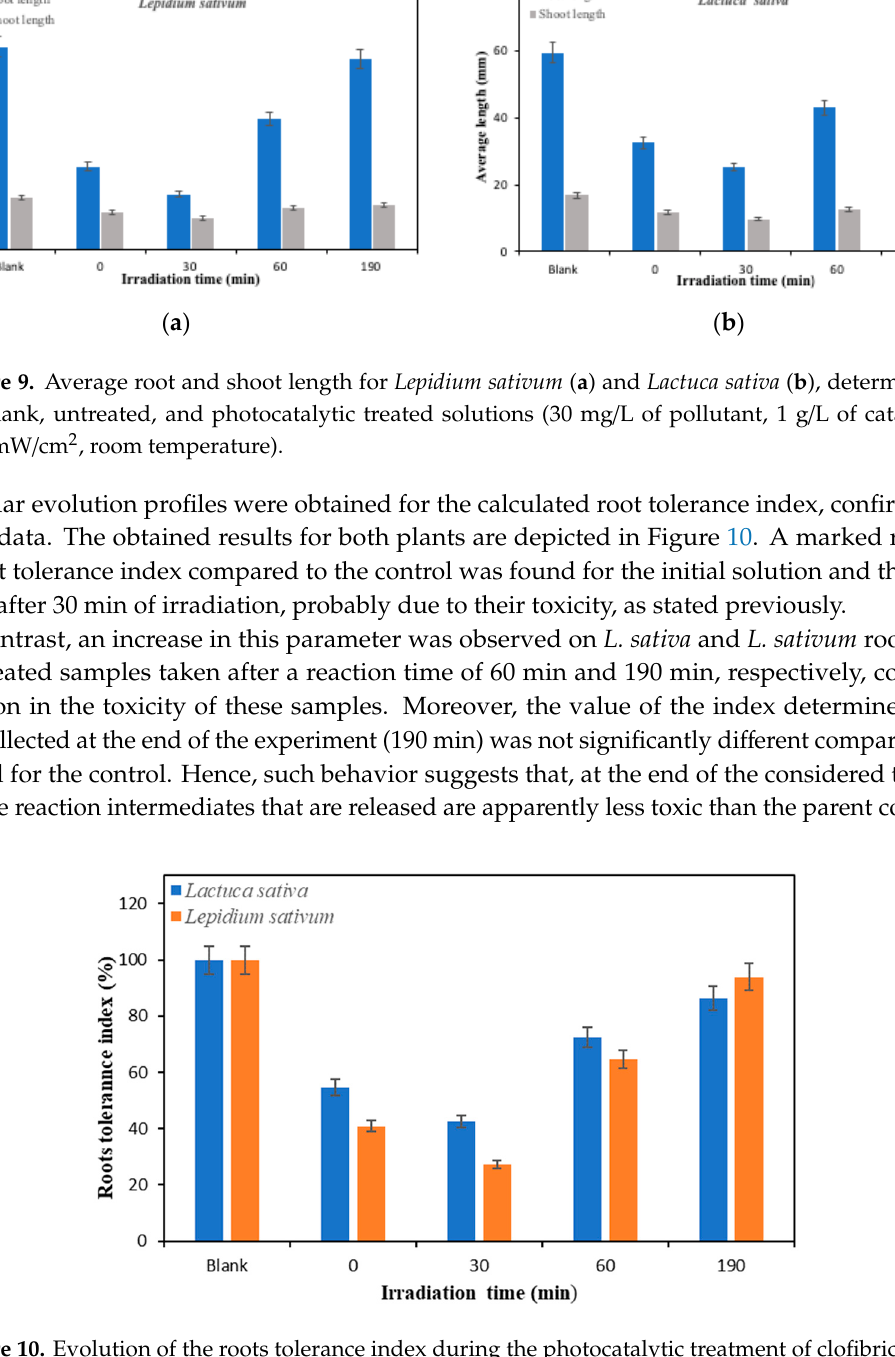
Figure 10. Evolution of the roots tolerance index during the photocatalytic treatment of clofibric acid (30 mg/L of pollutant, 1 g/L of catalyst, 9.52 mW/cm 2 , 26 ± 2 °C).